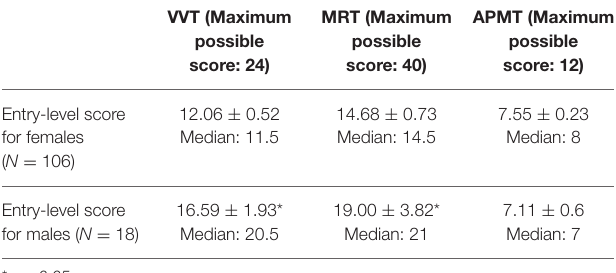
TABLE 1 | Mean ± SEM of female and male performance for the 3 tests of spatial and general reasoning abilities.